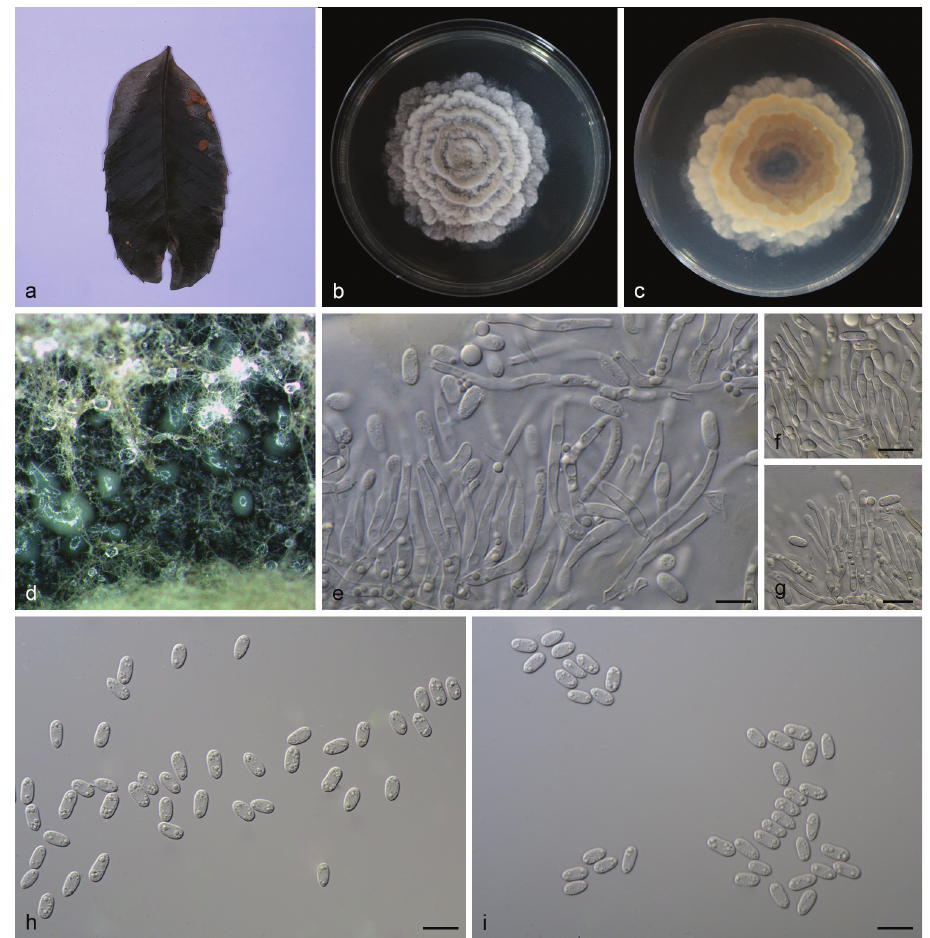
Figure 3. Obovoideisporodochium lithocarpi (SAUCC 0748). a infected leaf of Lithocarpus fohaiensis; b surface of colony after 15 days on MEA; c reverse of colony after 15 days on MEA; d conidiomata; e–g conidiophores, conidiogenous cells and conidia; h–i conidia. Scale bars: 10 μm ( e–i